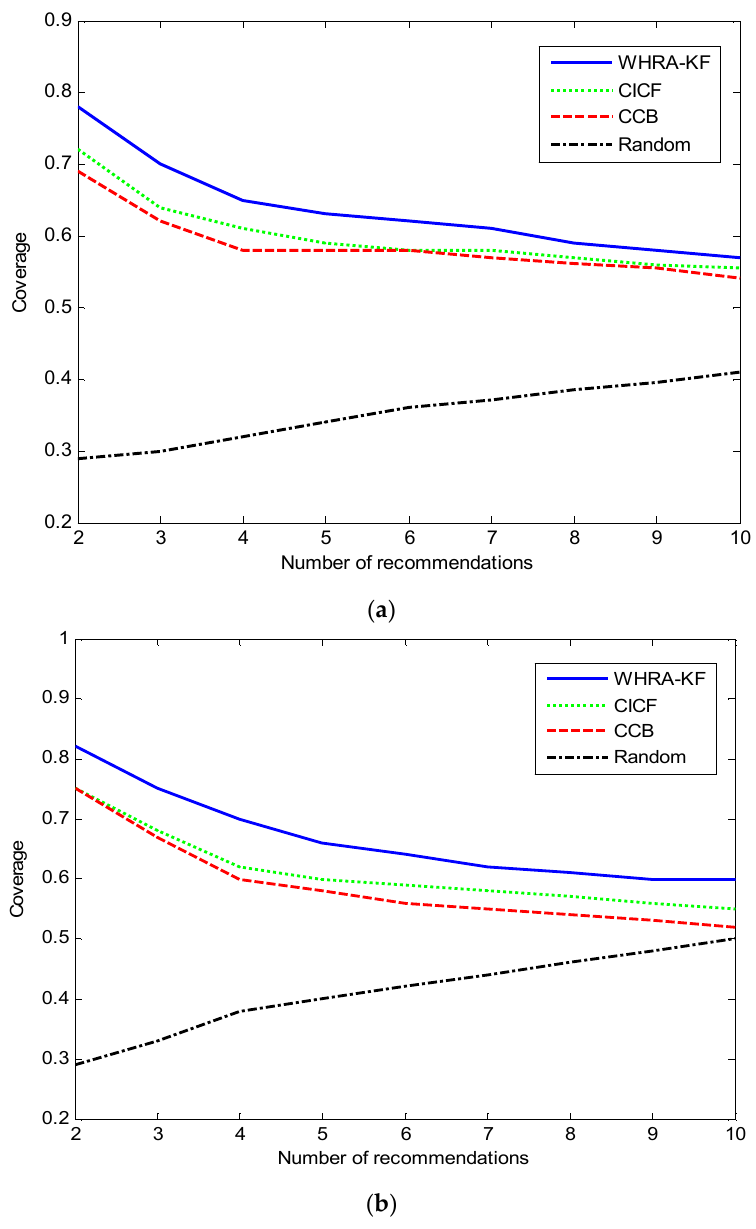
Figure 11. Coverage VS number of recommendation for smart home, ( a ) 50 n ; ( b ) 100 n .